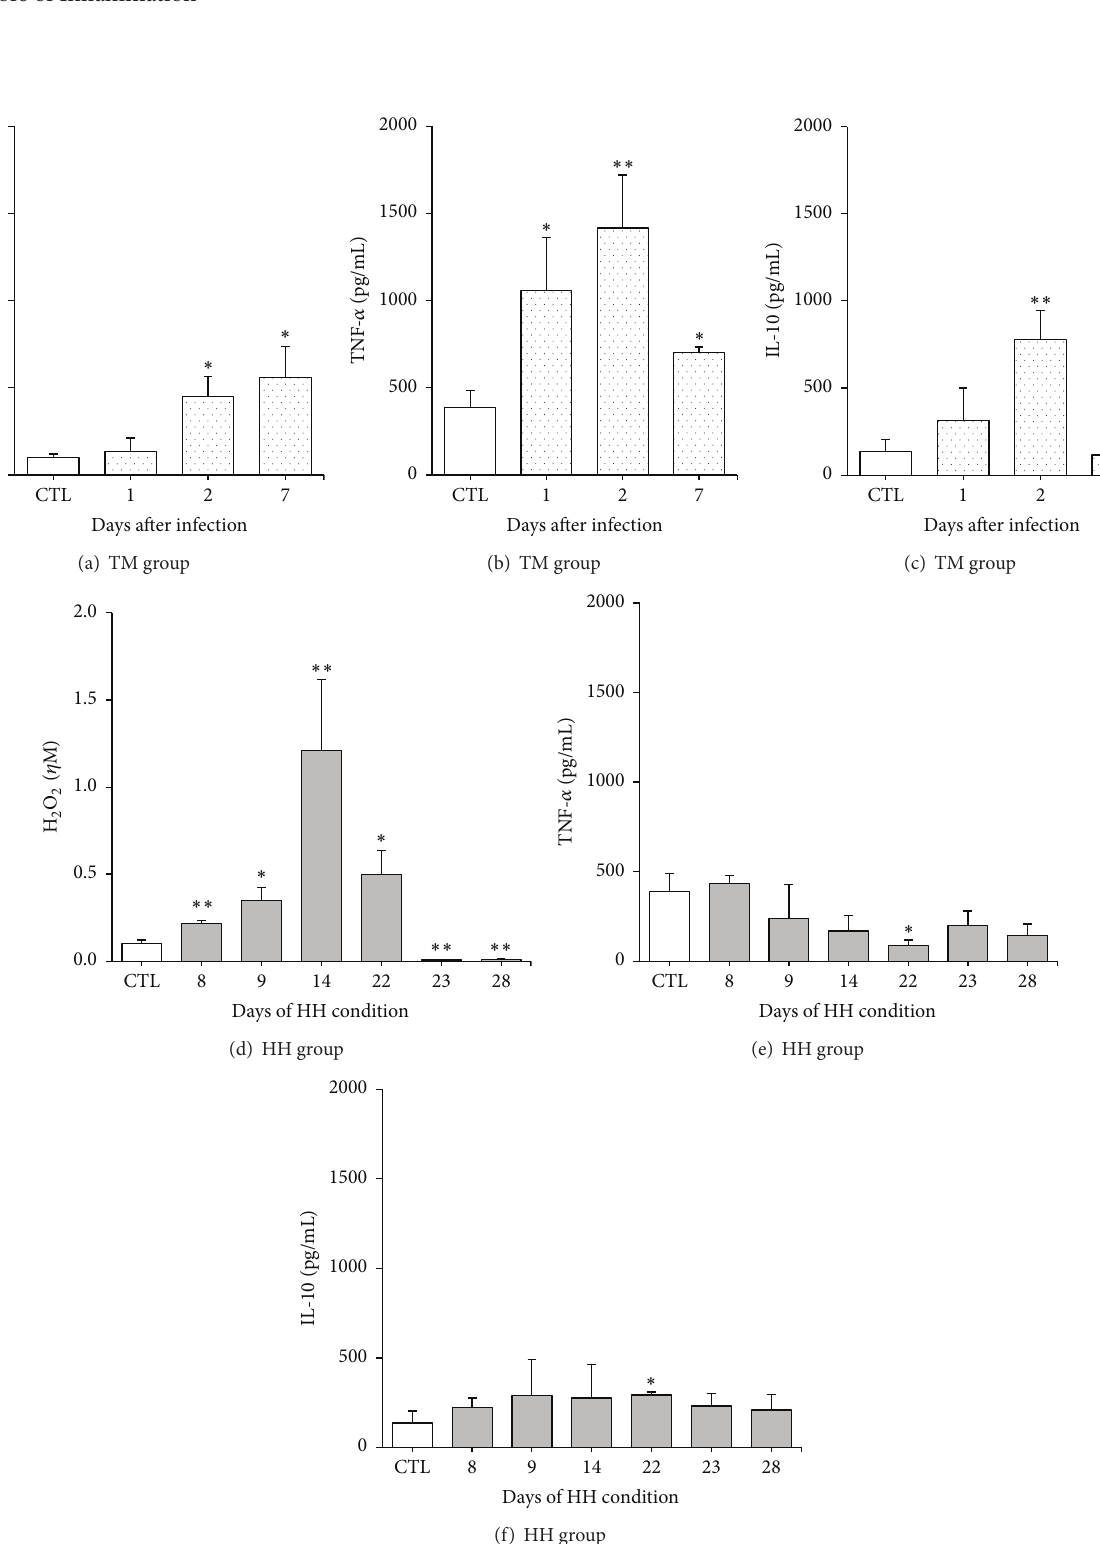
Figure 4: Kinects of hydrogen peroxide (H 2 O 2 ), tumor necrosis factor- (TNF-) 𝛼 , and interleukin- (IL-) 10 production by PAC from mice infected with T. mentagrophytes and HH mice. The results are expressed as mean ± SEM ( 𝑛 = 5 - 6 /group). Unpaired 𝑡 -test, 𝑝 < 0.05 . ∗ 𝑝 < 0.05 and ∗∗ 𝑝 < 0.01 indicate statistical differences between each experimental time point versus the control group (uninfected/HH-free